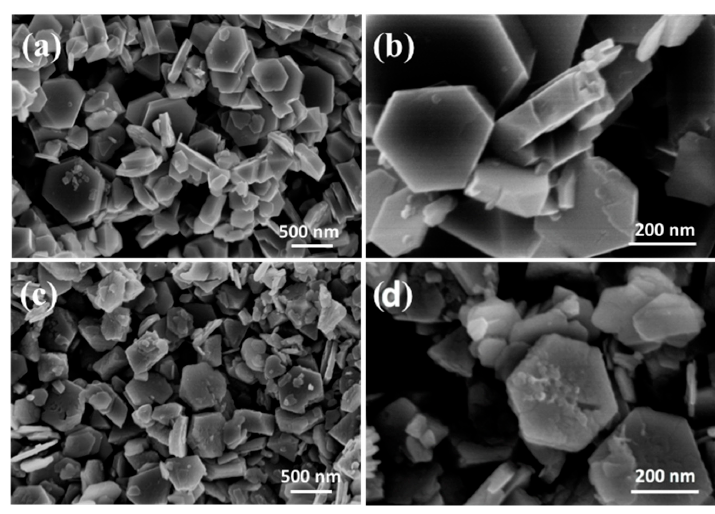
Figure 6. Scanning electron microscopy (SEM) images of LMO ( a , b ), HMO ( c ) and LMO-1 ( d ).